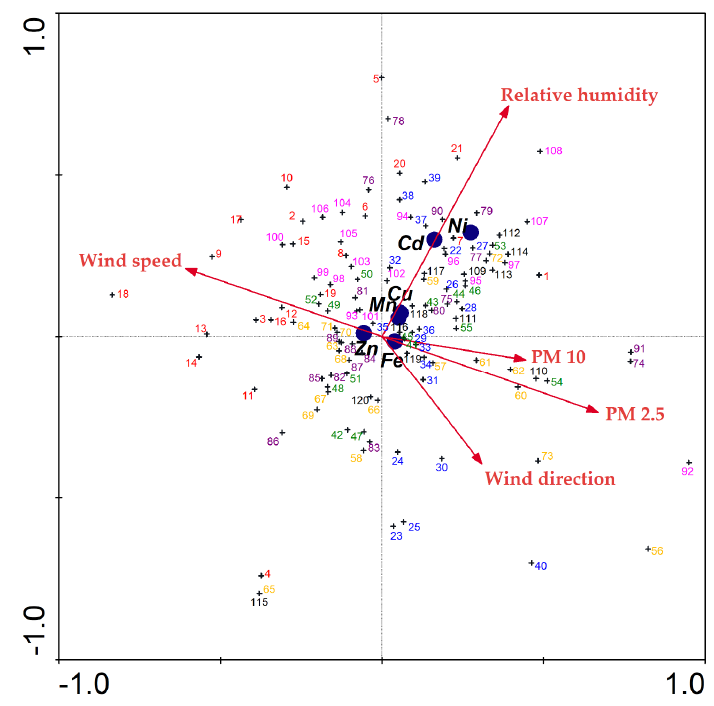
Figure 8. Graphical representation of the CCA between metal concentrations (in bold) and environmental variables (red arrow) for all studied sites. Numbers with different colors represent the events for each site, red (Pastora), green (Escobedo), yellow (Obispado), blue (Pueblo Serena), purple (Universidad), magenta (Santa Catarina) and black (Cadereyta).